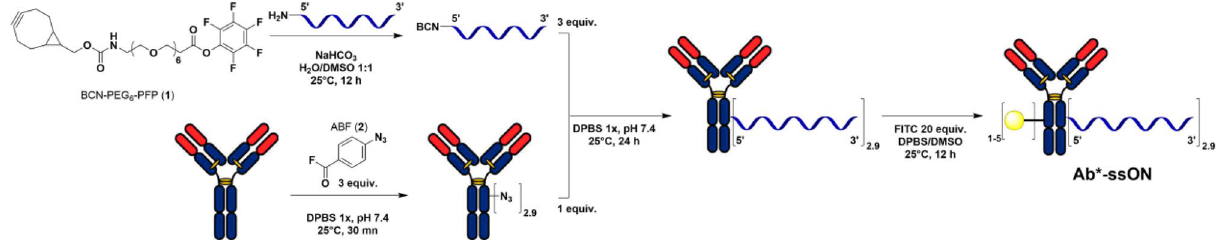
Figure 1. General scheme for the synthesis and labelling of Ab*-ssON conjugates.